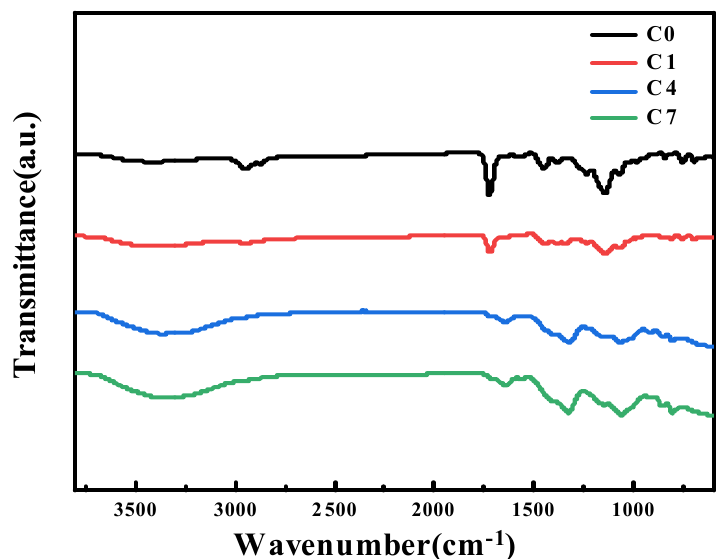
Figure 4. Infrared spectrum of coatings with and without modi fi